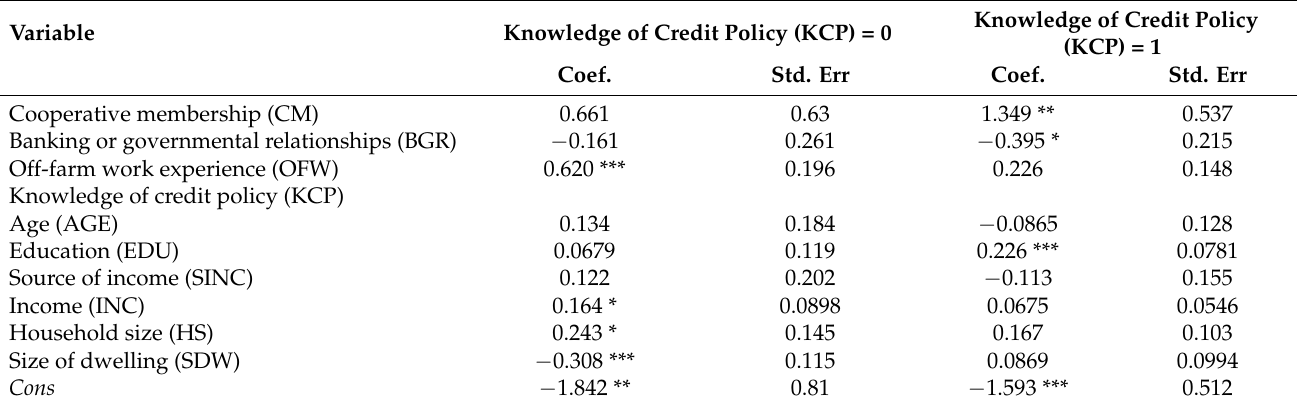
Table 7. Heterogeneity in the loan availability of cooperative membership by